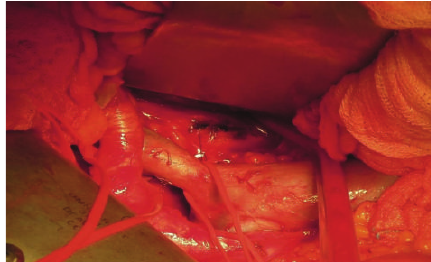
Figure 4: Intraoperative exposure of the tumor. The iliac vein was pulled upwards and medially with a widening of the operative field and the mass was finally removed, without traction, laterally. The haemostasis was